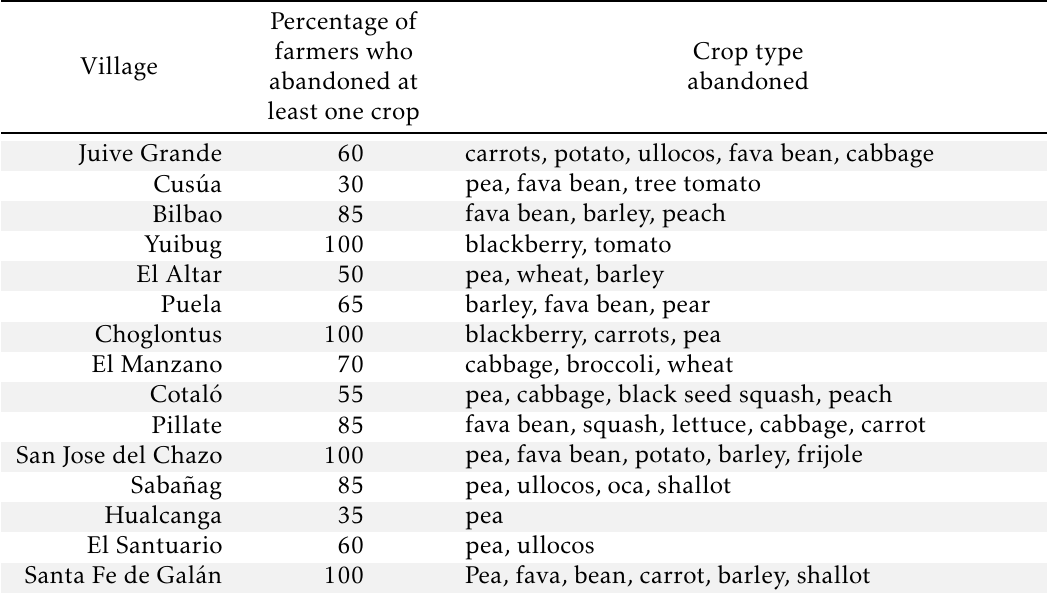
Table 2: Percentage of farmers in each of the 15 villages surveyed in 2014 who abandoned one or more crop types over the period